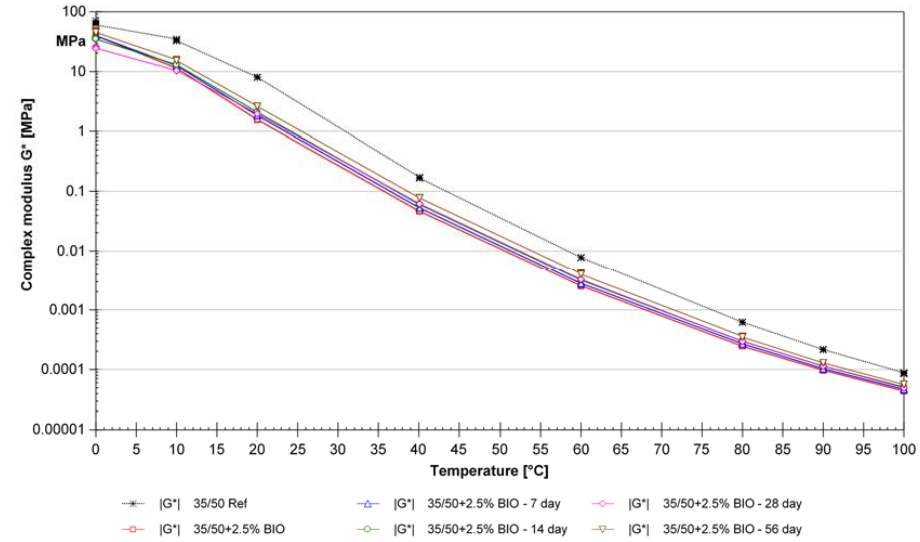
Figure 4. Changes of complex modulus |G*| in time for reference bitumen and 35/50 bitumen modified with 2.5% bio ‐ agent.